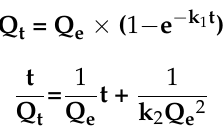
Formatted: Highlight